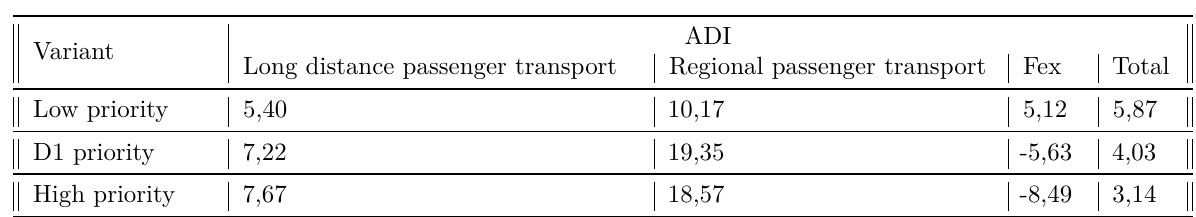
Table 1. ADI for different variants of priority of Fex trains.